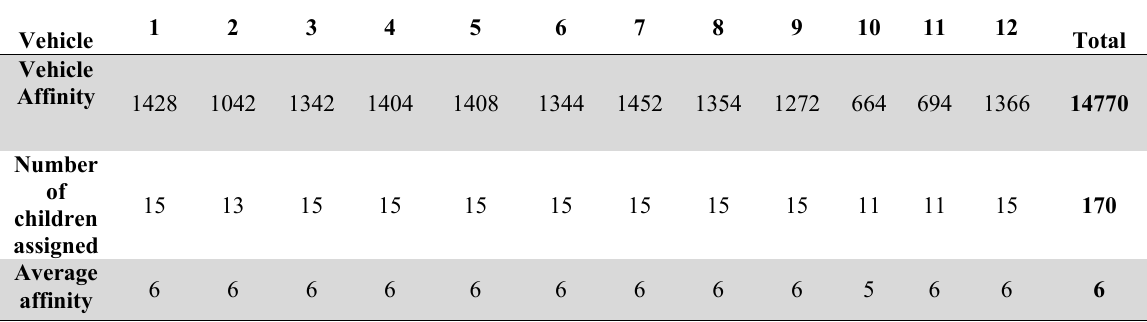
Results of the final assignment of